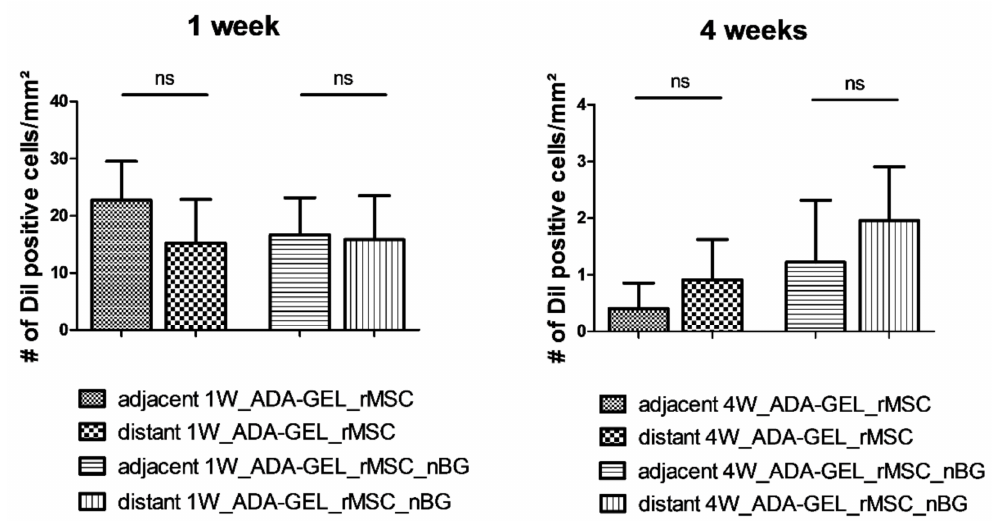
Figure 3. Mean number (+/ − SD) of DiI positive cells per mm 2 in different areas of the slide. Surprisingly, a higher number of DiI positive cells was present distant from the muscle after 4 weeks, compared to the areas adjacent to the muscle, although this difference was not statistically significant (ns) (Mann Whitney U Test).